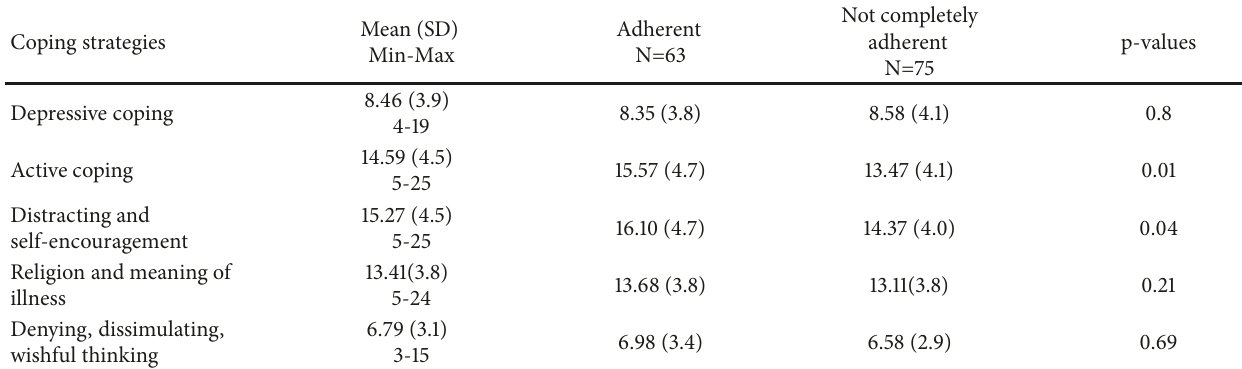
Table 3: Coping strategies and medication